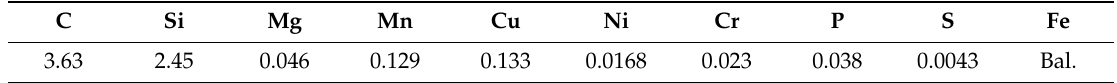
Table 1. Chemical composition of GJS 400 in wt %.